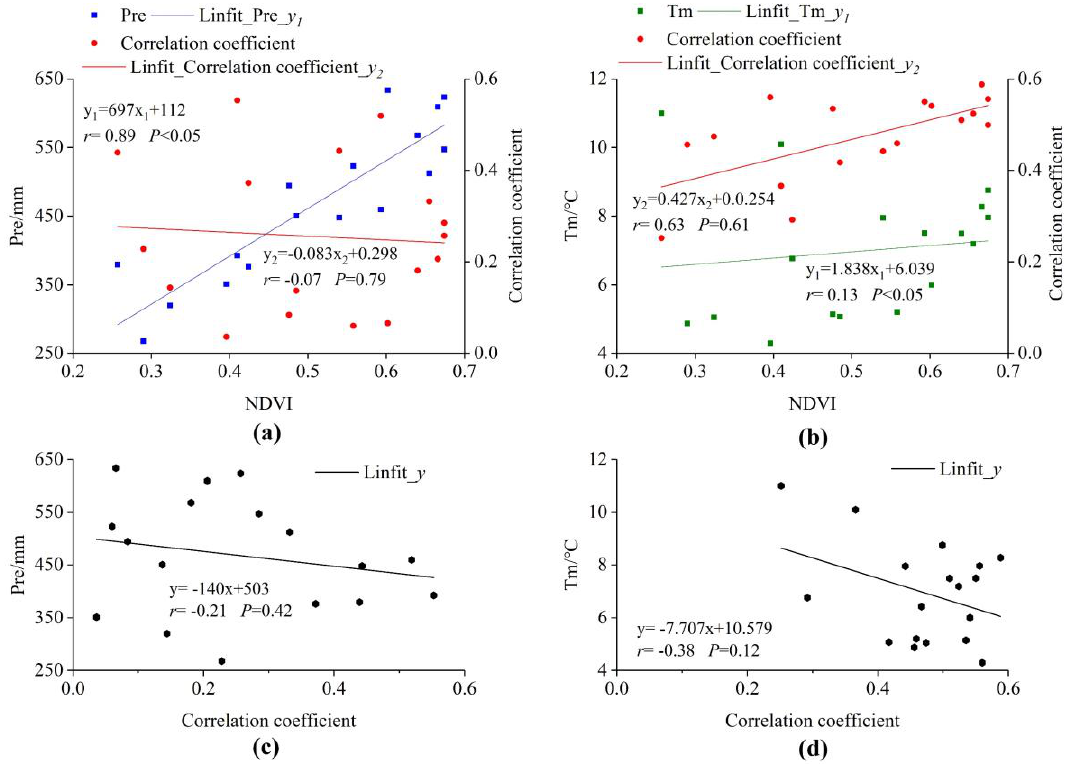
Figure 5. Correlation analysis in different counties for: ( a ) NDVI, precipitation, and correlation coefficient; ( b ) NDVI, temperature, and correlation coefficient; ( c ) precipitation and correlation coefficient; ( d ) temperature and correlation coefficient.